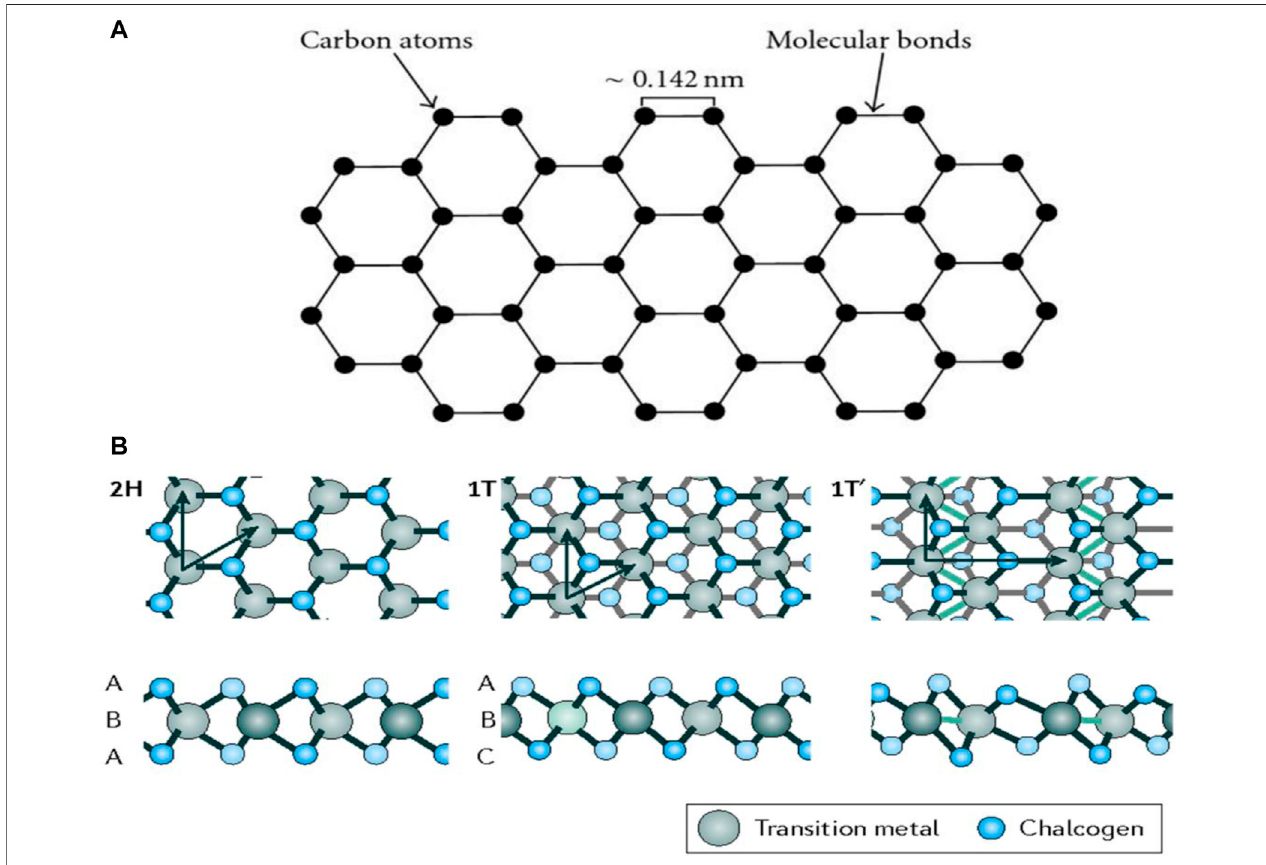
FIGURE4|(A) Graphene structure (Roberts et al.,2010),and (B) Single layered atomic structure ofTMDCsintrigonalprismatic(2H) distortedoctahedral(1T)and dimerized (1T ’ ) states (Manzeli et al., 2017). Adapted with permission from (Roberts et al., 2010; Manzeli et al.,